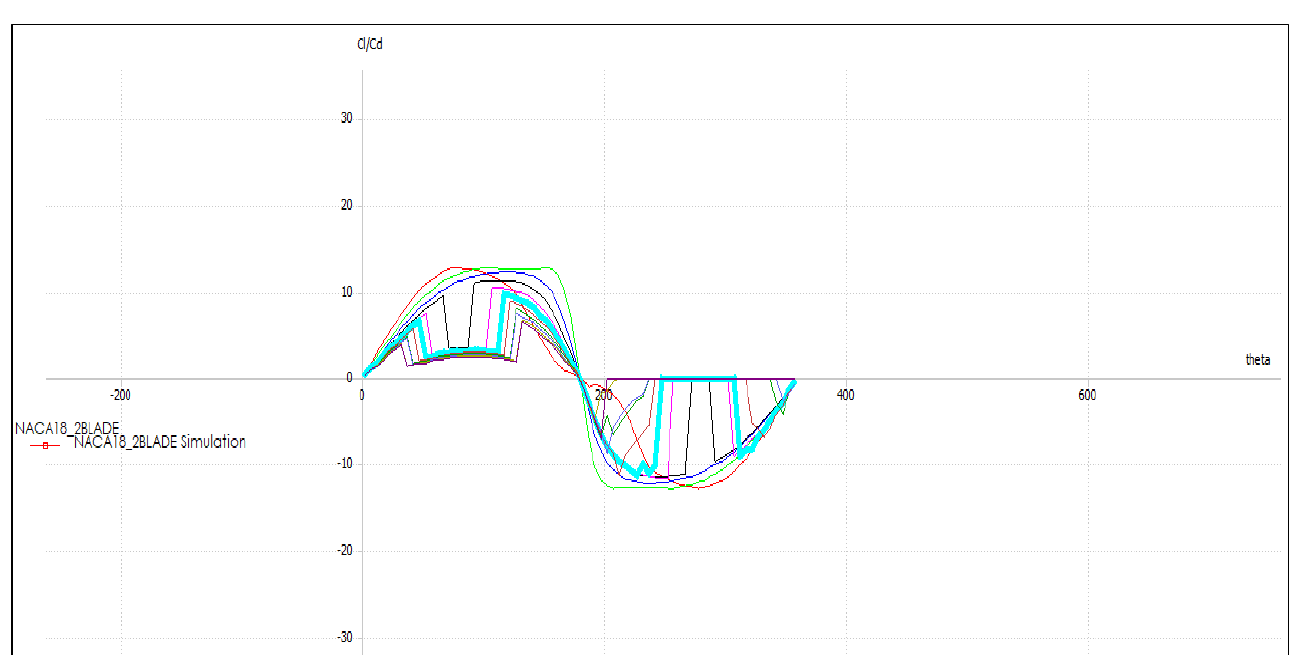
Figure 10. Cl/Cd vs theta plot of top-section for TSR 3.5